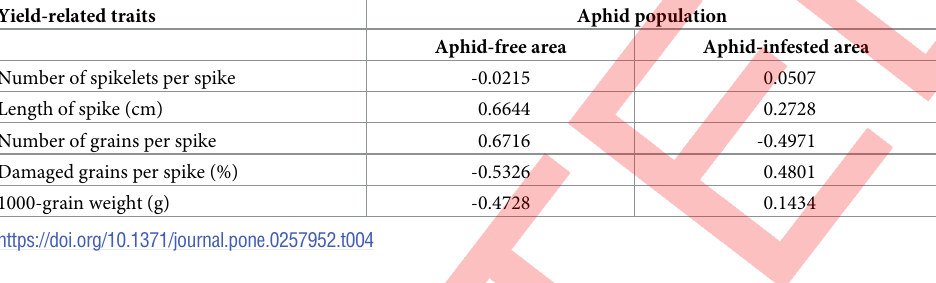
The results indicated that seed treatment with insecticides restricted the aphid population level in comparison with control by 62.59 to 87.96%, whereas plant extract suppressed aphid infestation by 17.09 to 61.37% (Table 5). Actara was the most effective as seed treatment with yield enhancement up to 1295.1 kh per Table 5. Economic analysis of different protection measures adapted to manage different aphid species in wheat crop during 2016 and 2017.